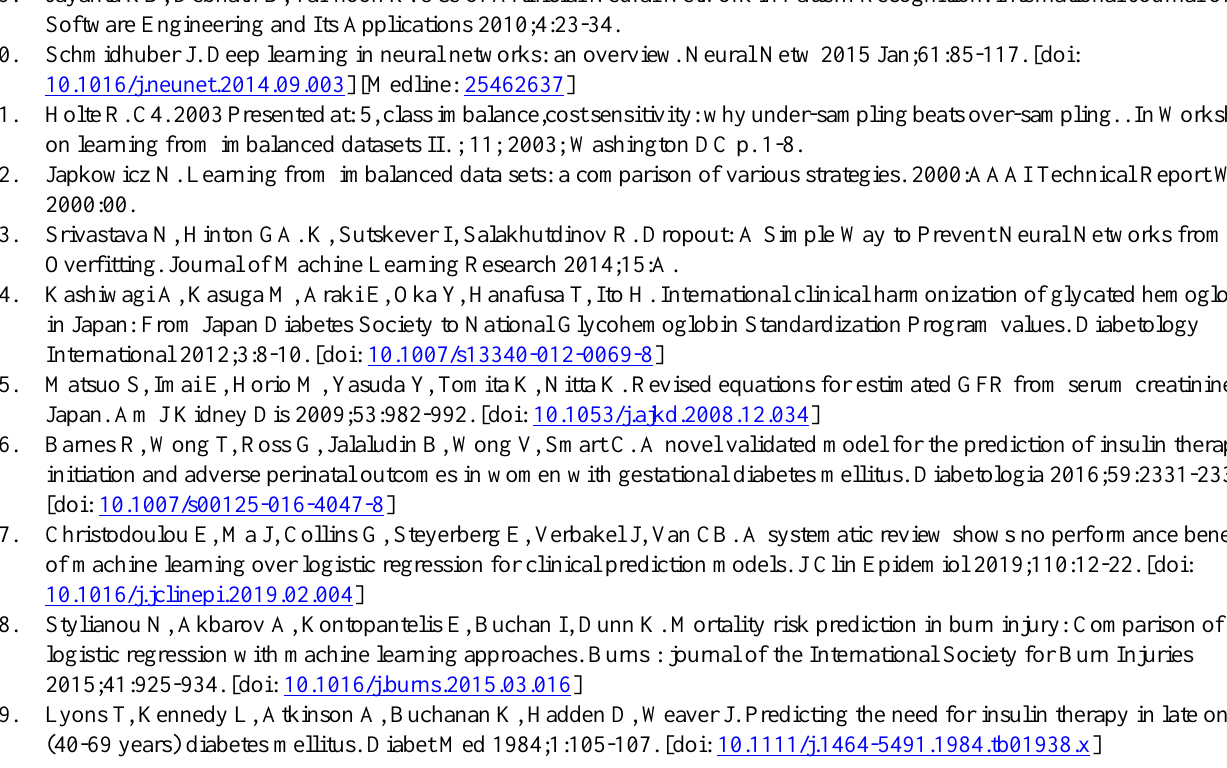
Abbreviations AUC: area under the receiver operating characteristic curve eGFR: estimated glomerular filtration rate HbA1c: glycated